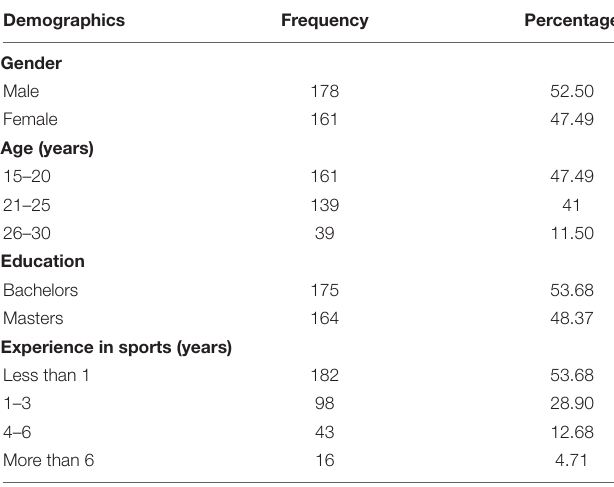
Cronbach alpha value of ( α = 0.917) which is above the minimum threshold mentioned for alpha